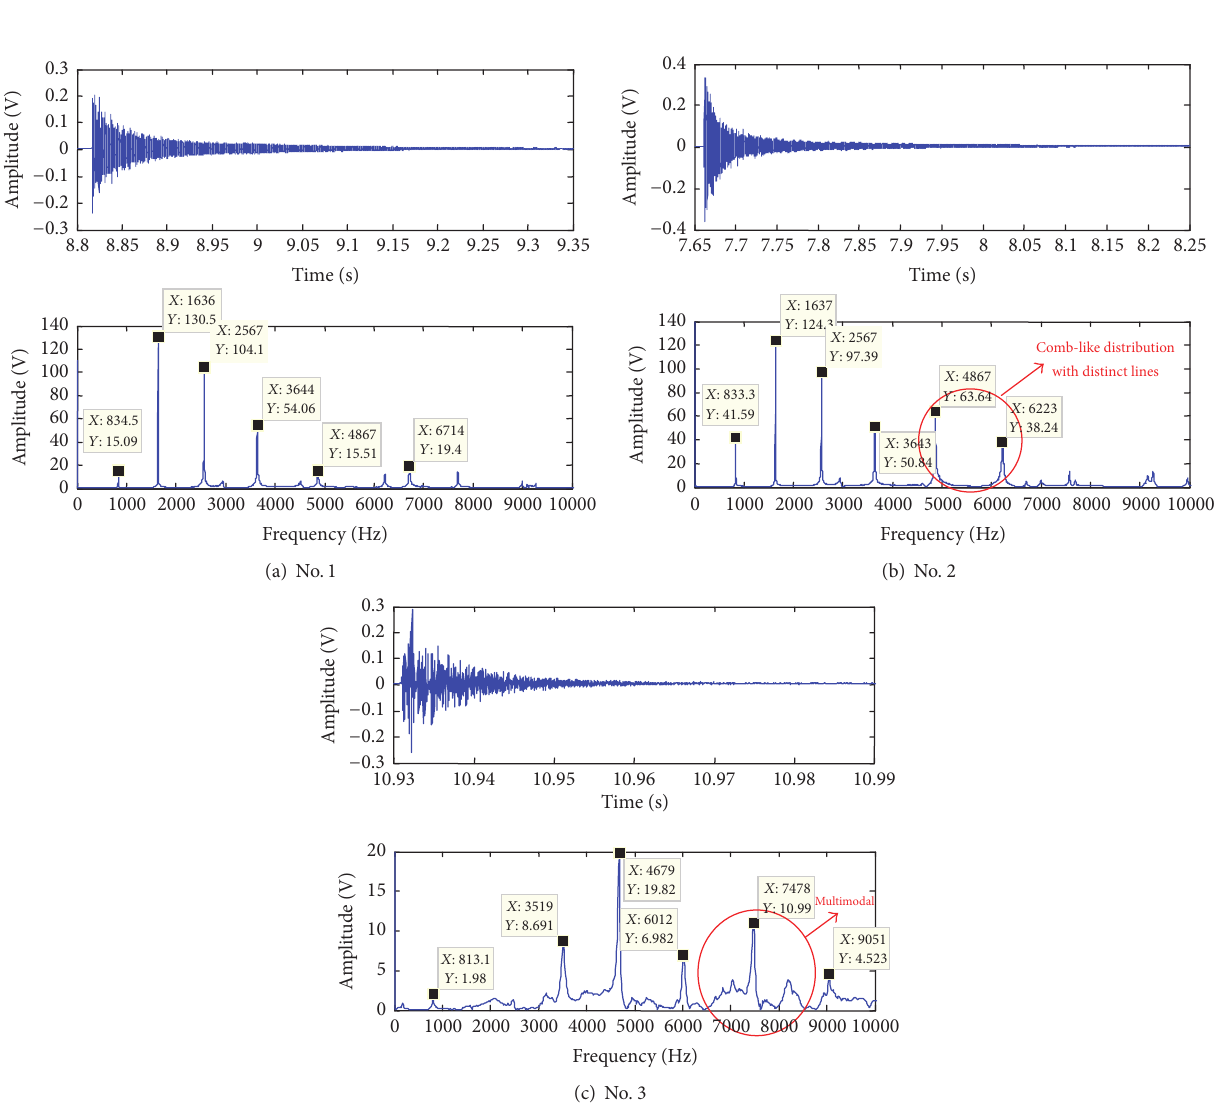
Figure 3: Time history and FFT of the plates